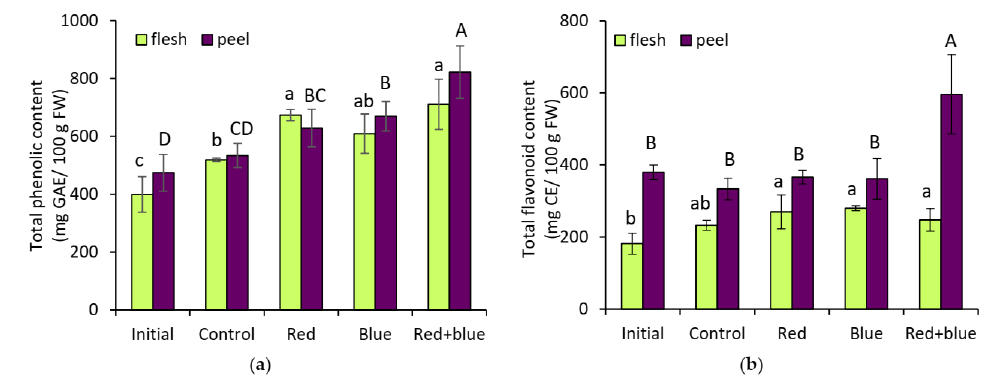
Figure 2. Effect of different LED lights on bioactive compounds: ( a ) total phenolic and ( b ) total flavonoid contents of eggplants. Different letters a–c and A–D indicate statistically significant differences ( p < 0.05), according to Duncan’s multiple range test of the flesh and peel, respectively. Error bars show means ± SD ( n =